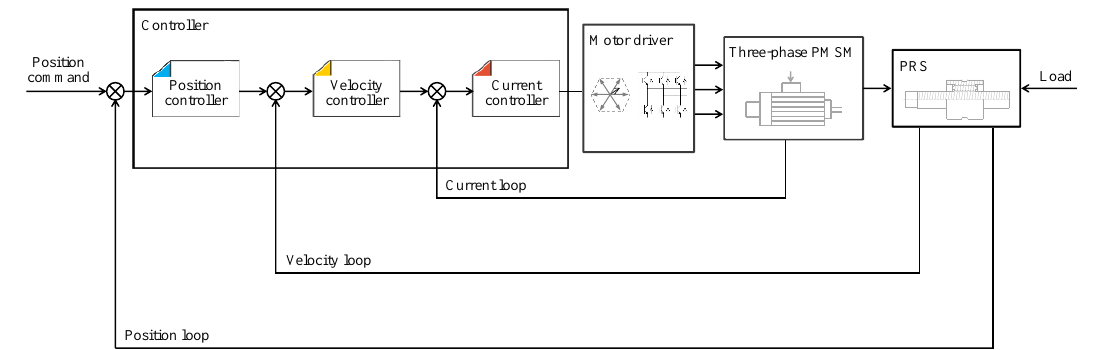
Figure 2. EMA Simulator.